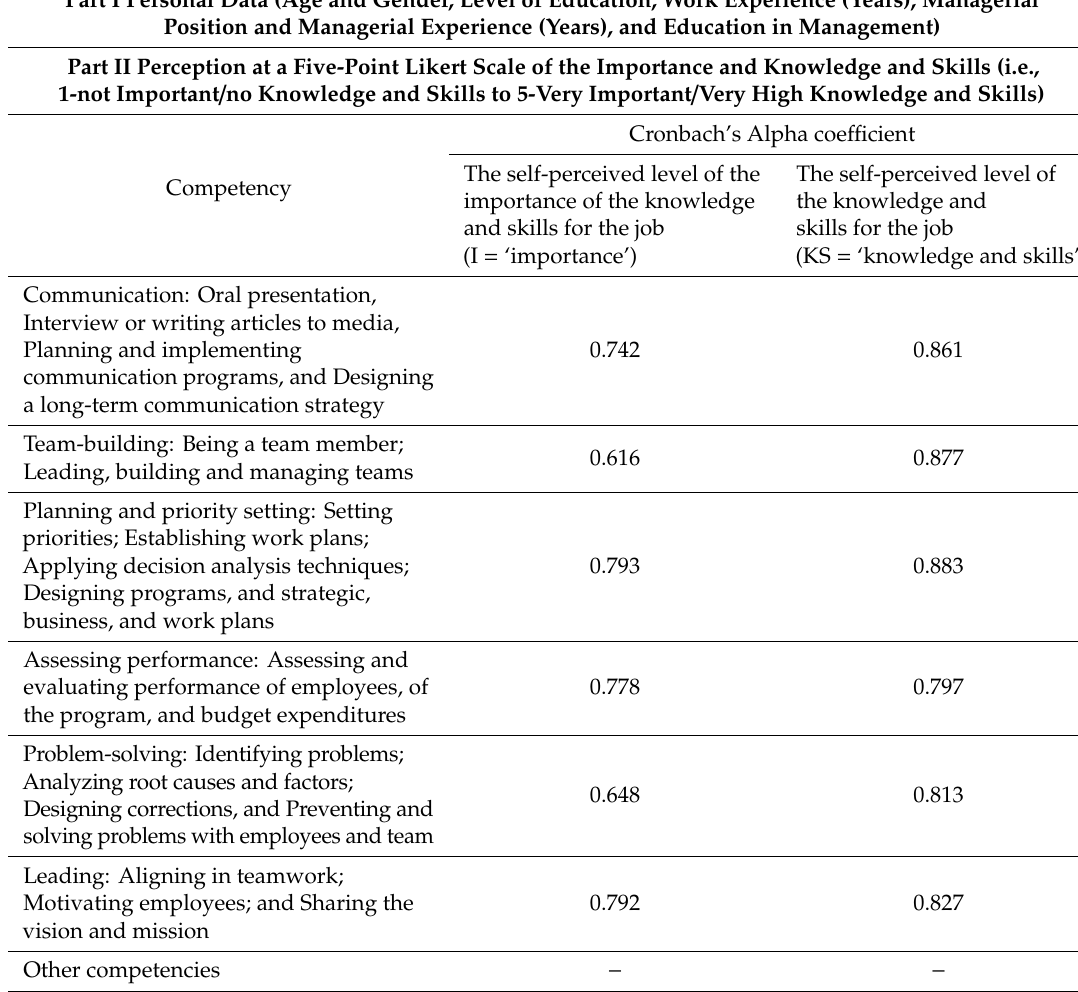
Table 1. Questionnaire